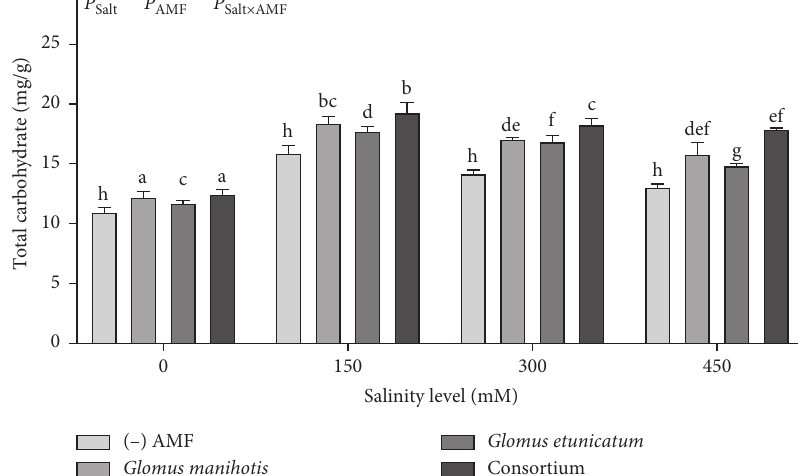
Figure 7: Effects of AMF inoculation on the total carbohydrate content of L. leucocephala leaves at different NaCl stress. AMF: arbuscular mycorrhizal fungi. ∗ : significant at 0.01 ≤ P ≤ 0 . 05; ∗∗ : significant at P ≤ 0 . 01. Bars that do not share a letter are significantly different at P ≤ 0 .